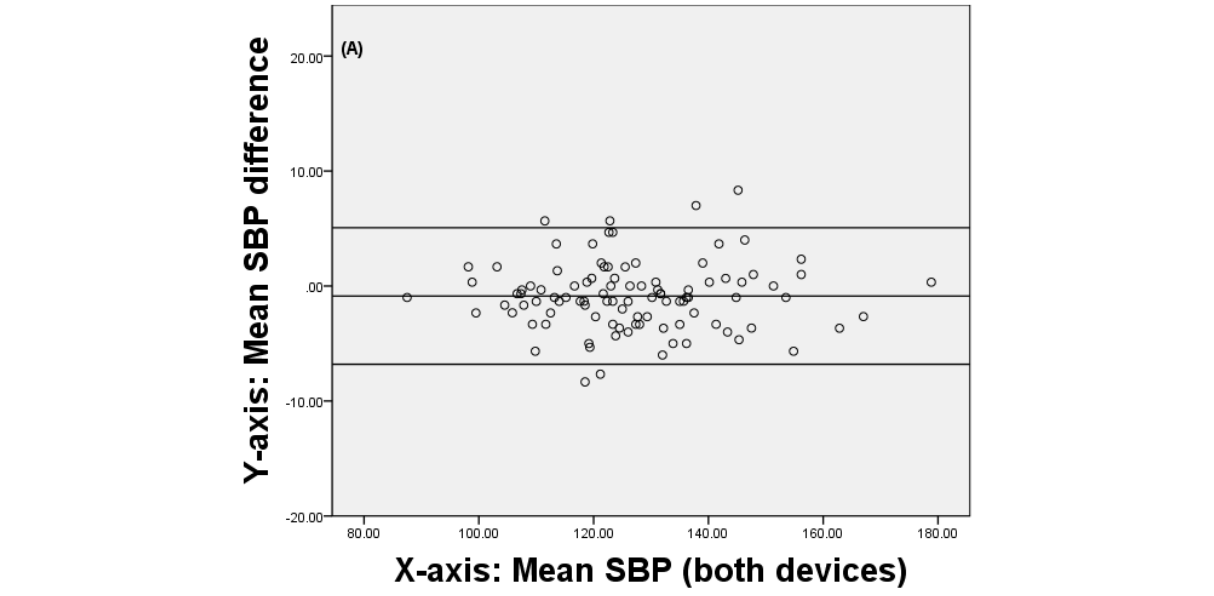
Figure 3. Bland-Altman plot comparing QardioArm and Omron devices for systolic blood pressure (SBP), for individual participants in session